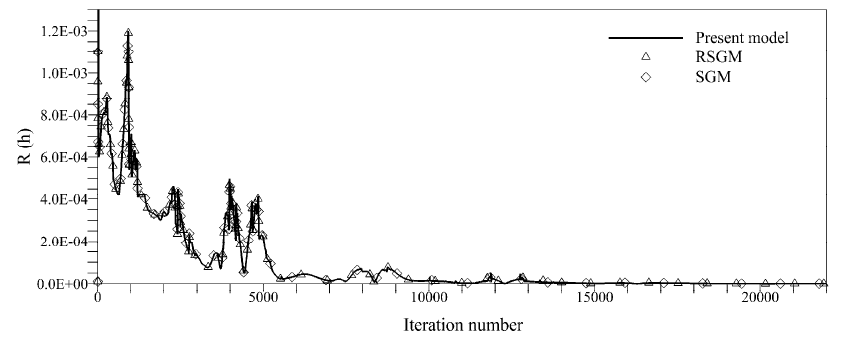
Figure 10. Comparison of water surface elevation for subcritical flow.